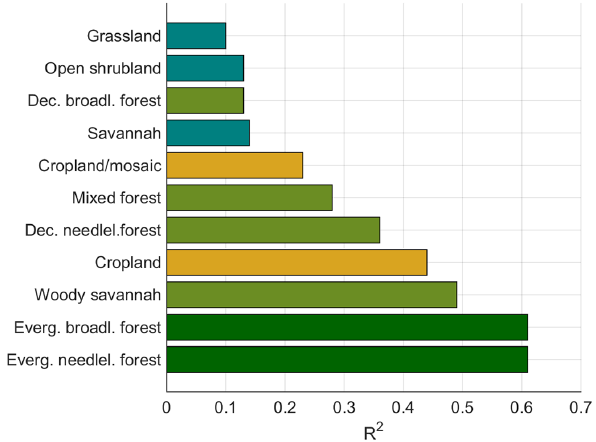
Figure B1. Coefficient of determination R 2 of the multiple linear regression model of S R,CRU-SM (based on P CRU and E SM ) based on the climate variables interstorm duration I isd , precipitation sea- sonality I s , and aridity I a . The green bars are forests or wooded land, the yellow bars represent croplands, and the teal bars repre- sent short vegetation